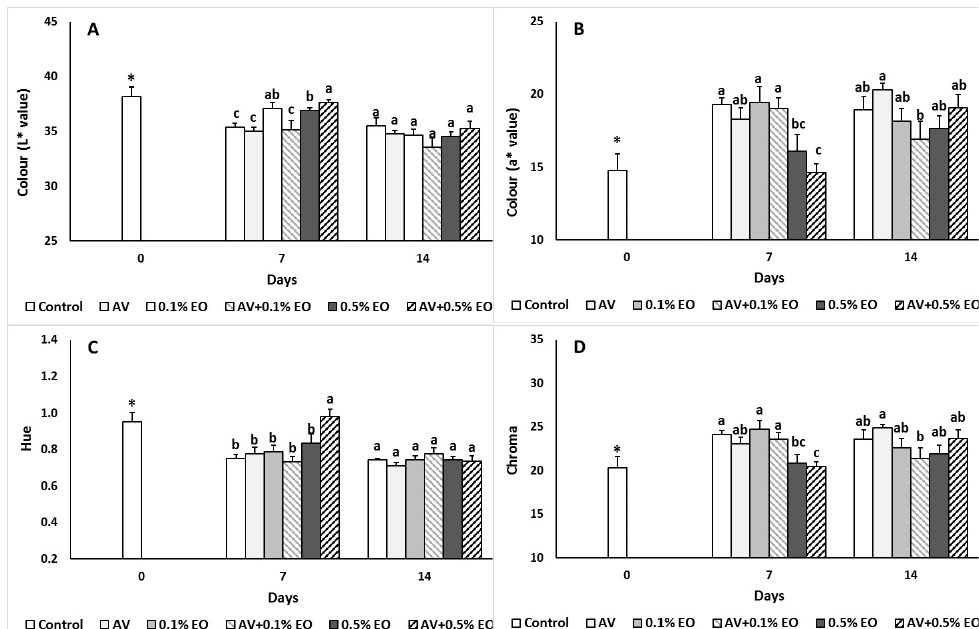
Figure 2. Impacts Aloe vera (AV at 10%) coating and/or sage essential oil (EO at 0.1% and 0.5%) on ( A ) L* , ( B ) a* , ( C ) hue and ( D ) chroma values in tomato fruit following storage for 7 and 14 days. Fruit